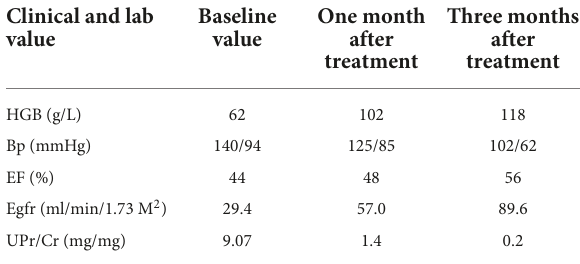
protein ( Figure 3 and Table 1 ). Her blood homocysteine level decreased, and the condition of her coronary artery dramatically returned to normal: left main coronary artery diameter 2.6 mm (Z = + 1.20), anterior descending branch diameter 2.0 mm